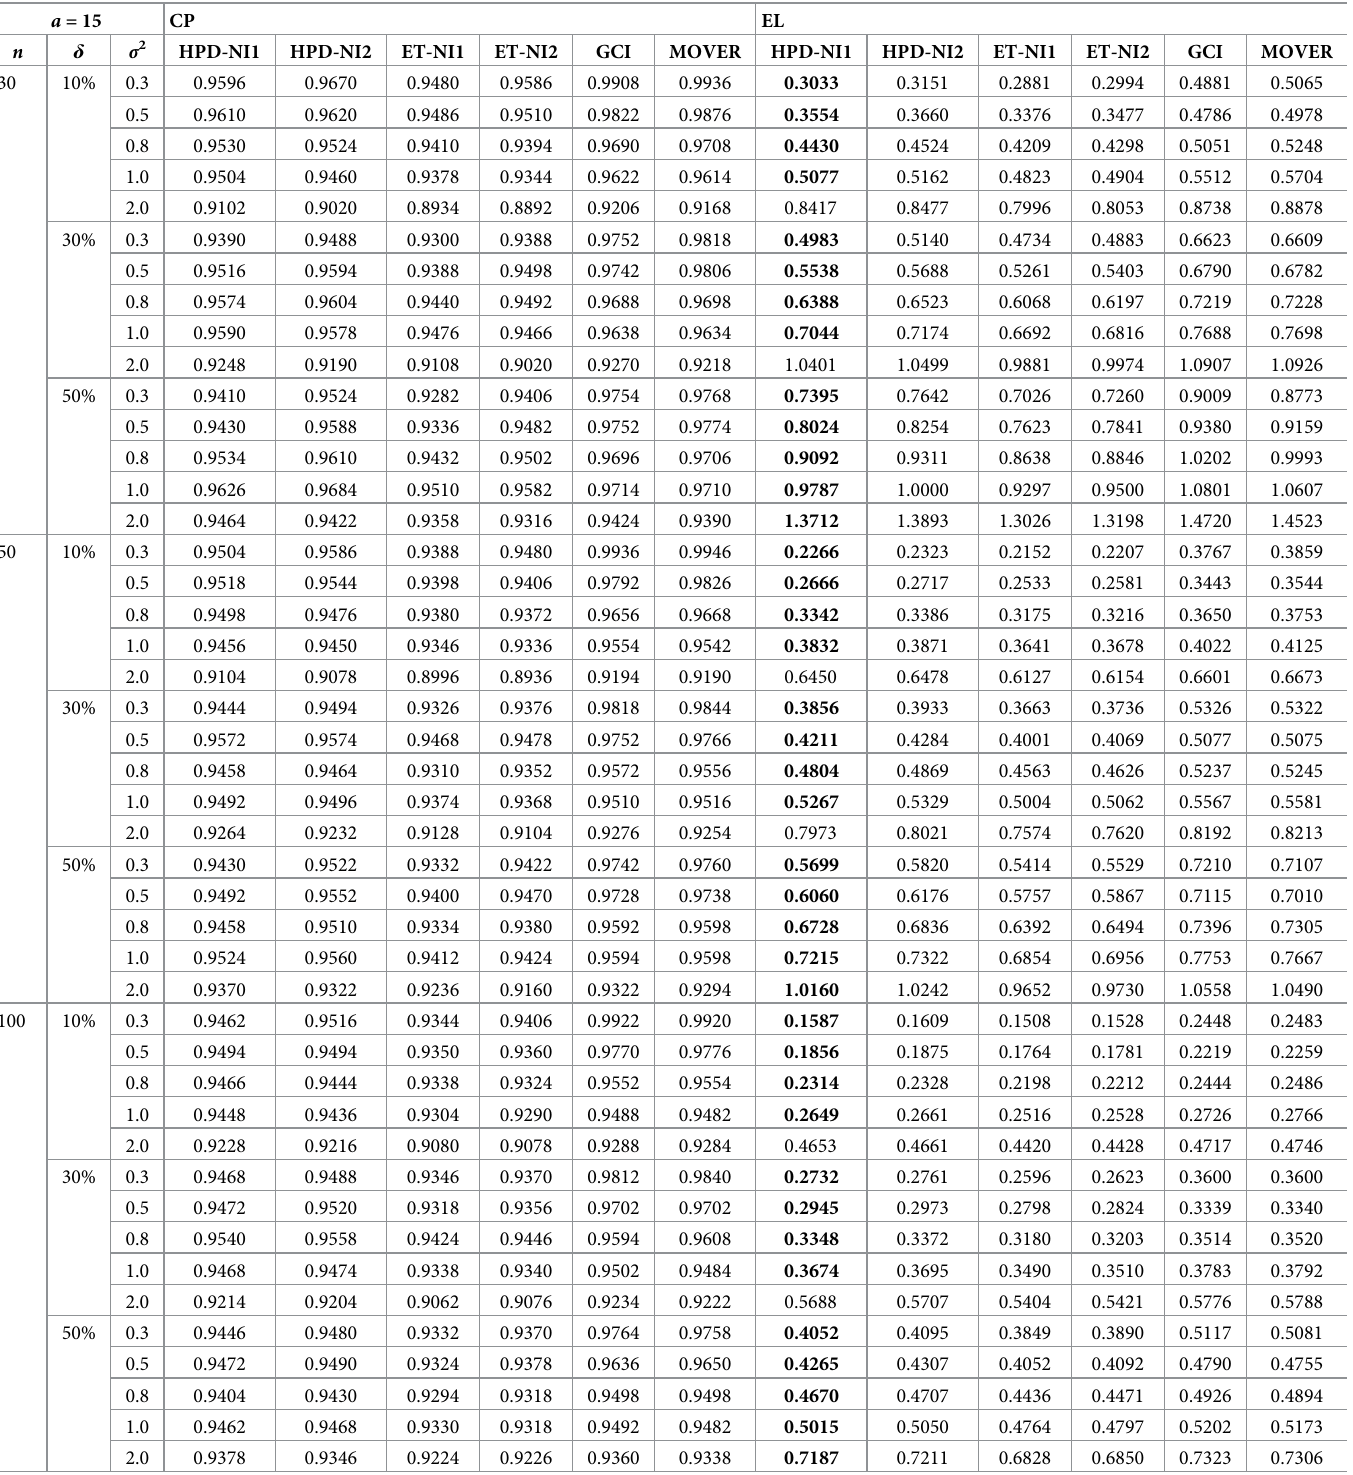
Table 3. CP and EL performances of 95% CI for θ : a =